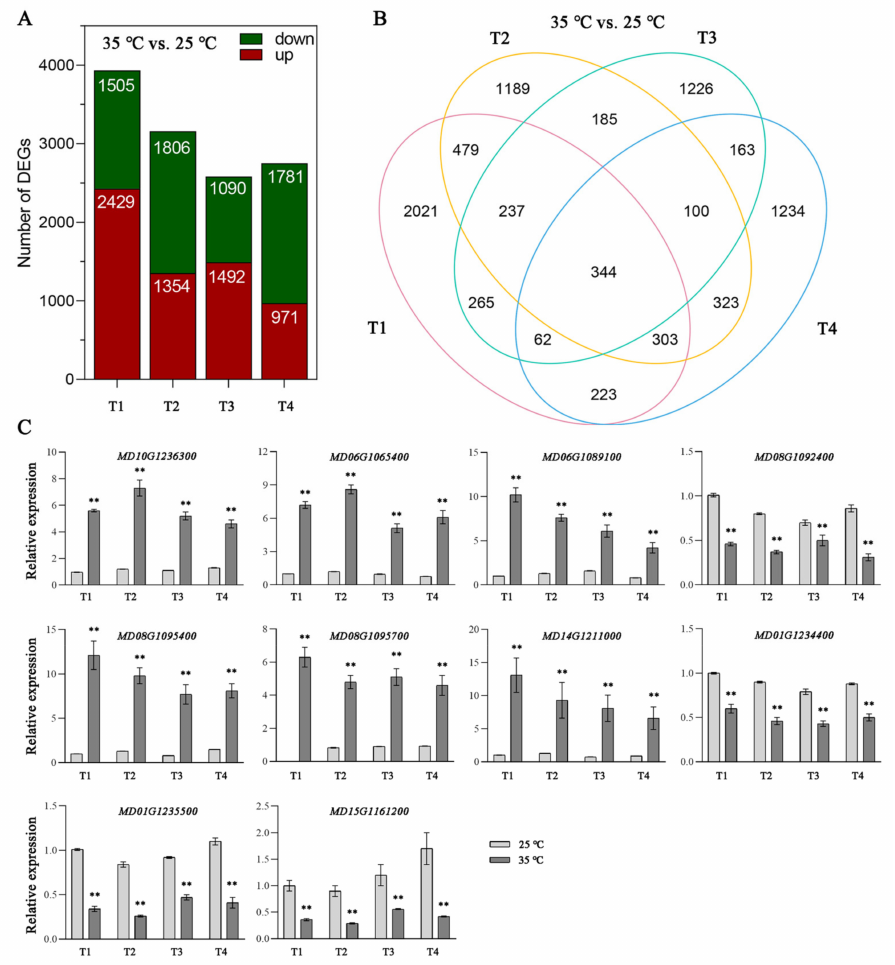
Figure 2. Histogram and Venn diagram showing numbers of differentially expressed genes (DEGs) in the comparisons 35 ◦ C vs. 25 ◦ C at T1, T2, T3, and T4. ( A ) Histogram showing DEGs in the comparisons 35 ◦ C vs. 25 ◦ C at T1, T2, T3, and T4. ( B ) Venn diagram presenting the overlap of DEGs in the comparisons 35 ◦ C vs. 25 ◦ C at T1, T2, T3, and T4. ( C ) Expression levels analysis of 10 selected DEGs by qRT-PCR. T1, T2, T3, and T4 represent apples after 3, 6, 9, and 12 days of 25 ◦ C and 35 ◦ C treatment, respectively. Values stand for means ± SD of three independent biological replicates. Statistical significance was measured using Student’s t -test (** p <